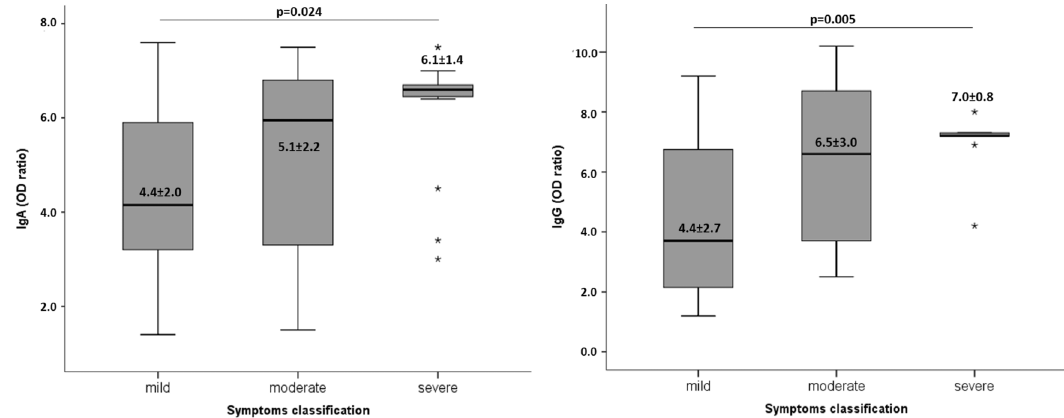
Figure 2 - Boxplots representing the IgA and IgG OD ratios according to symptom classifications. The box values are means ± standard deviations, and analysis of variance performed comparisons with Bonferroni as an ad-hoc test. The significant p -values were included in the